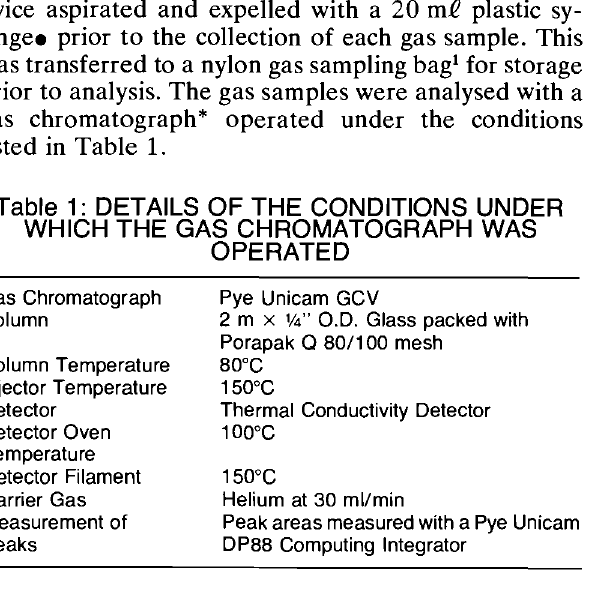
Table 1 : DETAILS OF THE CONDITIONS UNDER WHICH THE GAS CHROMATOGRAPH WAS